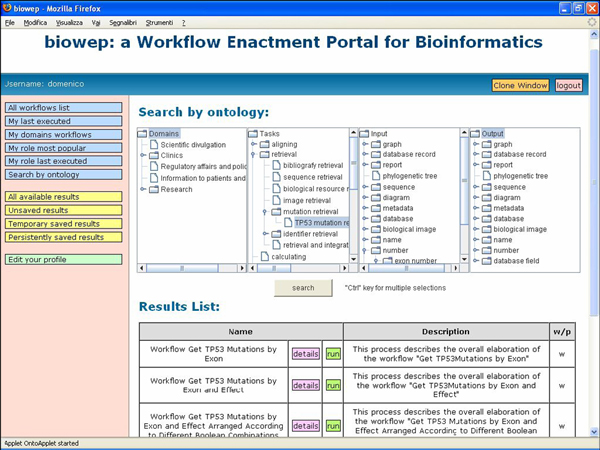
"Search by ontology" page, allowing to search workflows by their annotations. In this figure, the web page allowing for the "search by ontology" is shown. Columns include, from left to right, the application domain, the task, the input and the output. Multiple conditions that are set on each column are combined by OR, and conditions that are imposed on different columns are combined by AND. Results of the search are displayed in the lower part of the same page and include both workflows and single steps.